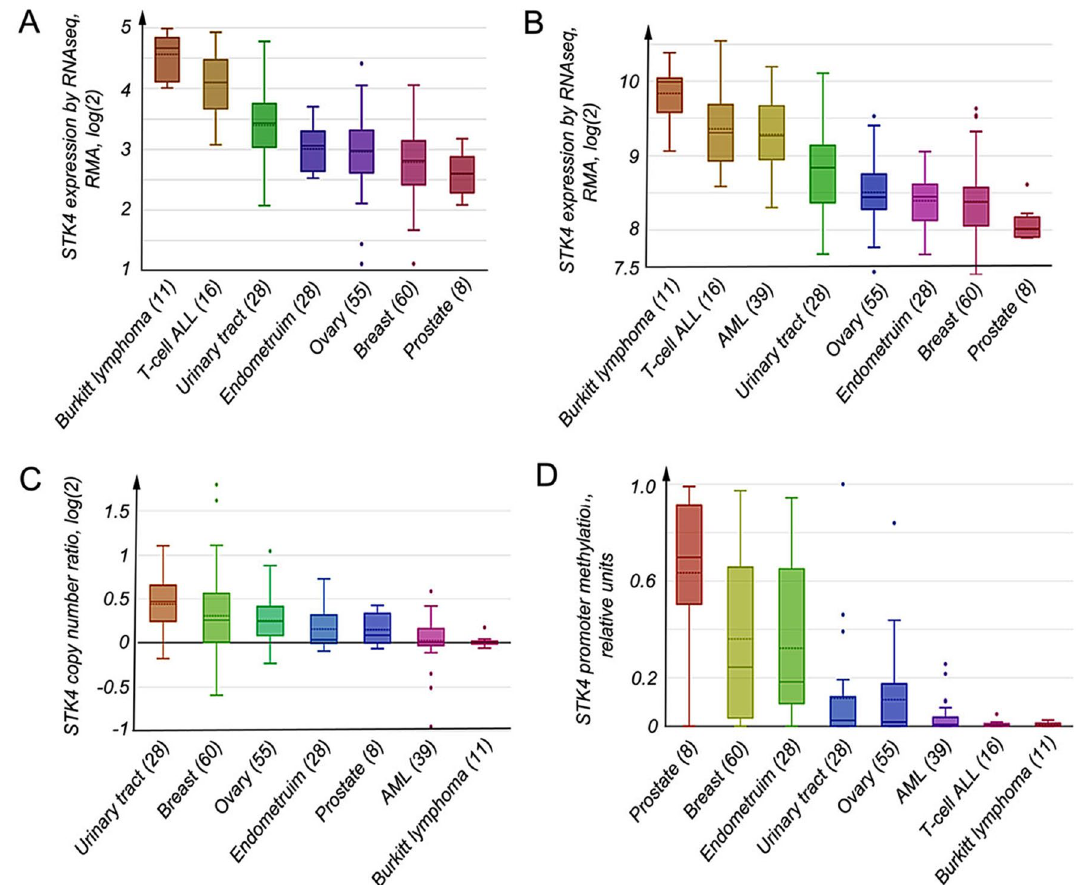
Figure 4. The STK4 gene expression pattern, obtained at the Broad Institute portal. ( A ) STK4 mRNA expression in various tumor cell lines, according to RNAseq.; ( B ) STK4 mRNA expression according to microarray studies; ( C ) the STK4 gene copy number ratio, calculated based on mRNA expression in normal tissue and cancer cell lines (16). Note that the highly expressed STK4 in Burkitt lymphoma has only 2 copies (20 × 2 = 2), while in solid tumors there is a gain in copy number values (up to 3 copies in EC cell lines: 20.75 × 2 = 3.3); ( D ) methylation of the STK4 promoter, obtained by reduced representation bisulfite sequencing (RRBS). The STK4 promoter methylation is quite high in EC, prostate cancer, and breast cancer cell lines, i.e., in hormone-driven cancers of the human reproductive system. RMA robust multichip averaging, relative